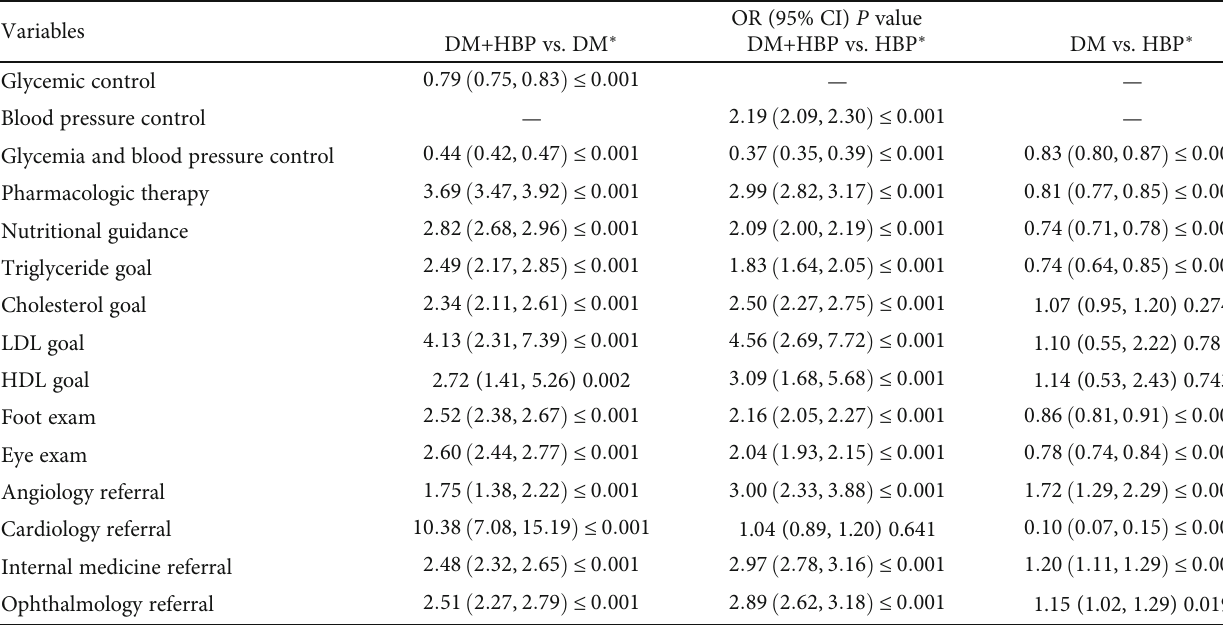
Table 3: Comparison between groups for reaching goals through odds